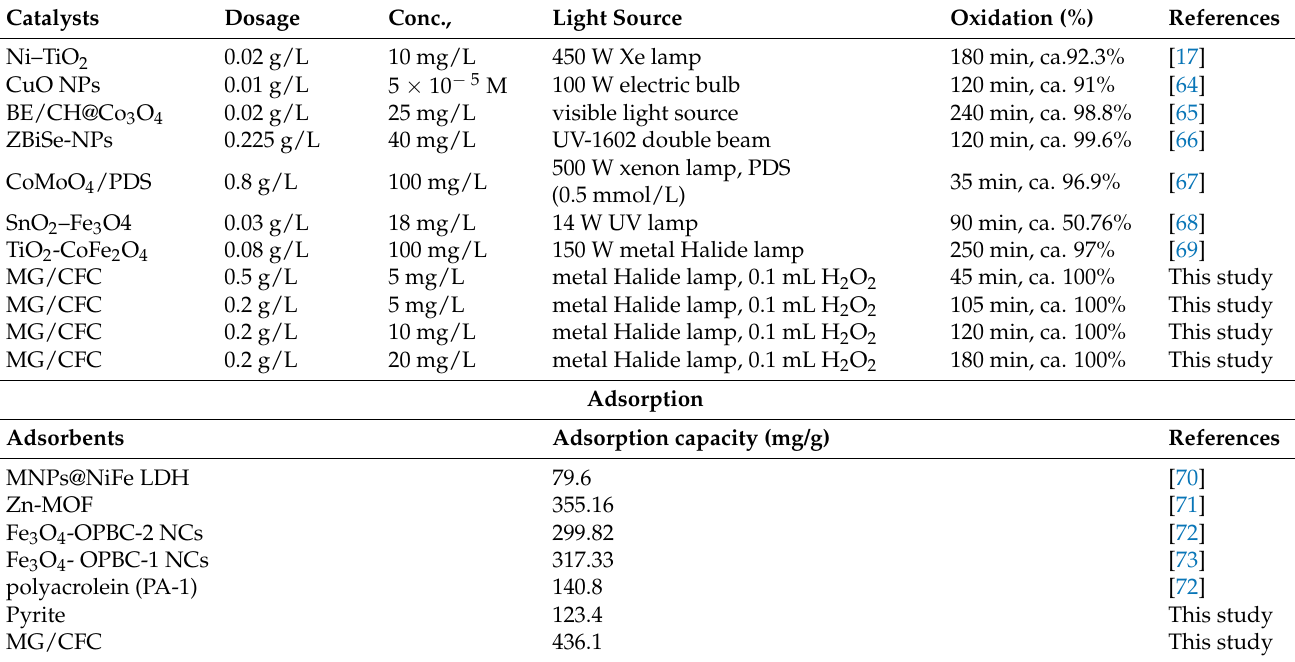
Table 4. Comparison between the adsorption and catalytic activities of MG/CFC and other studied materials in